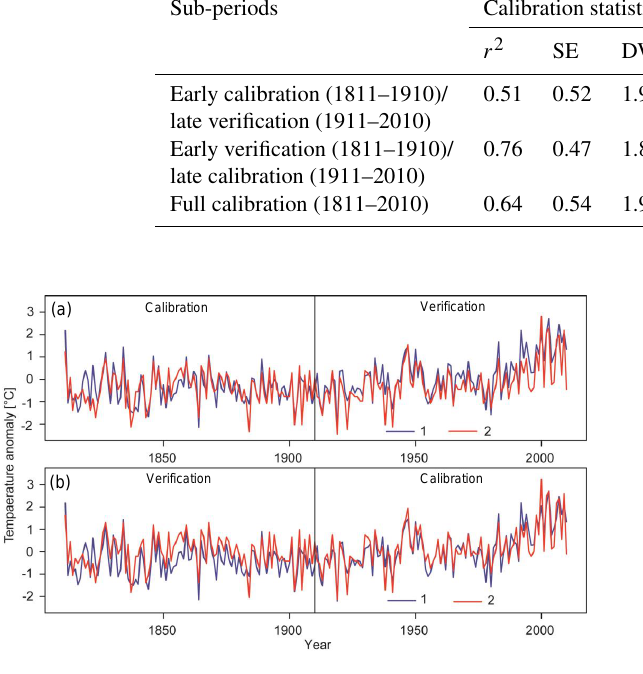
Figure 6. Comparison of measured (1) and reconstructed (2) mean Czech April–August temperatures: anomalies with respect to the 1961–1990 period. Variance scaling method of reconstruction was performed for (a) early (1811–1910) and (b) late (1911–2010) cal- ibration periods.